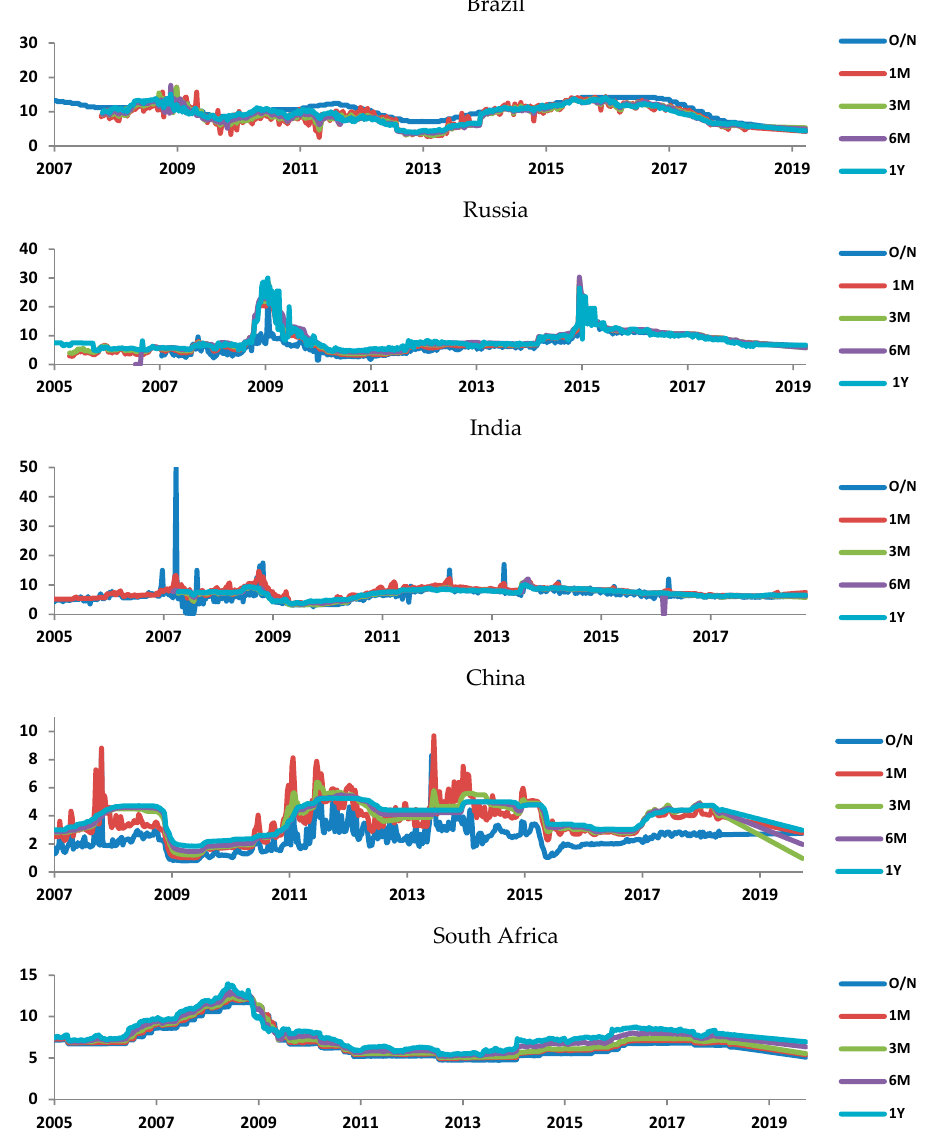
Figure 1. Treasury bills interest rates for BRICS countries. Note : O / N, 1M, 3M, 6M, 1Y denote the overnight and one-, three-, six- months and one year Treasury bills rates for Brazil, Russia, India, China, and South Africa, spanning the period from January 2005 to August 2019.